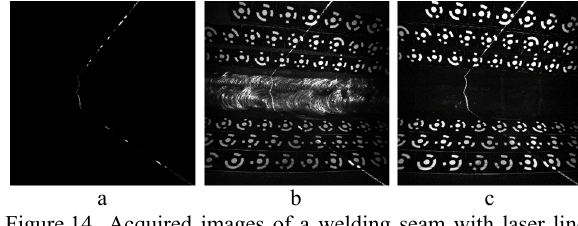
Figure 14. Acquired images of a welding seam with laser line and photogrammetric paper targets; (a) short exposure time; (b) compromising exposure time; (c) crossed polarising